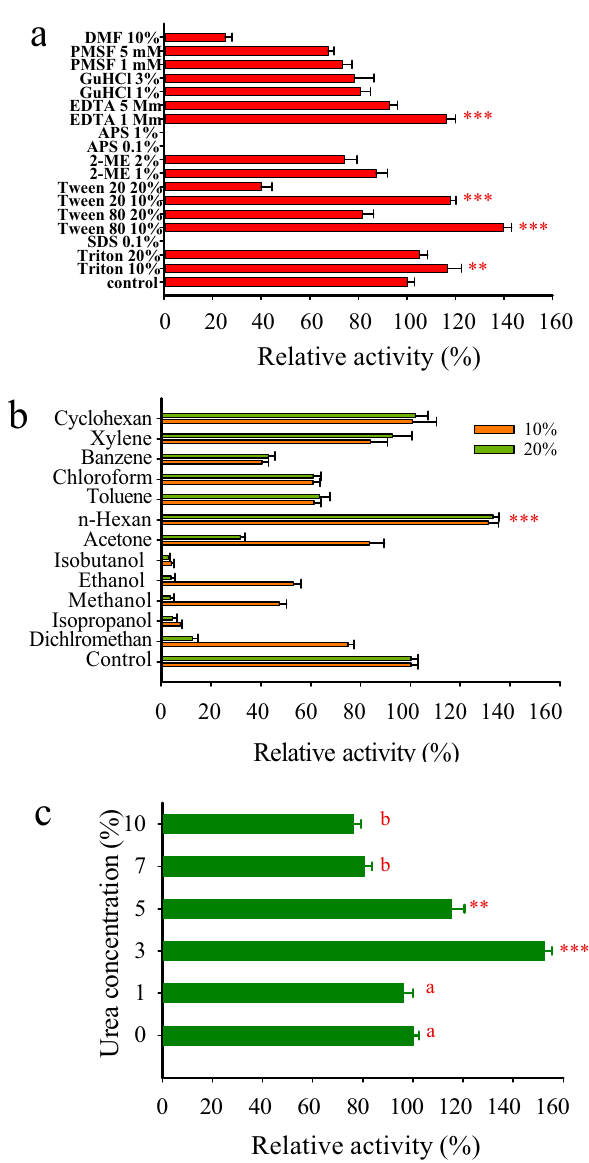
Figure 2. ( a ) Effects of surfactants, reducing and oxidizing agents, and inhibitors on Xyn-2 activity. ( b ) Effects of organic solvents on the enzyme activity. ( c ) Relative activity of Xyn-2 in various concentrations of urea. All reactions were conducted at 20 °C and pH 5 in citrate buffer. The enzyme activity in the buffer-only condition (control) was taken as 100% and the activities obtained under the influence of the inhibitors and denaturants were expressed relative to that. The stars indicate a significant increase in the enzyme activity at p ≤ 0.001 (***) and p ≤ 0.01 (**) compared to control. The groups indicated by the same letter are not significantly